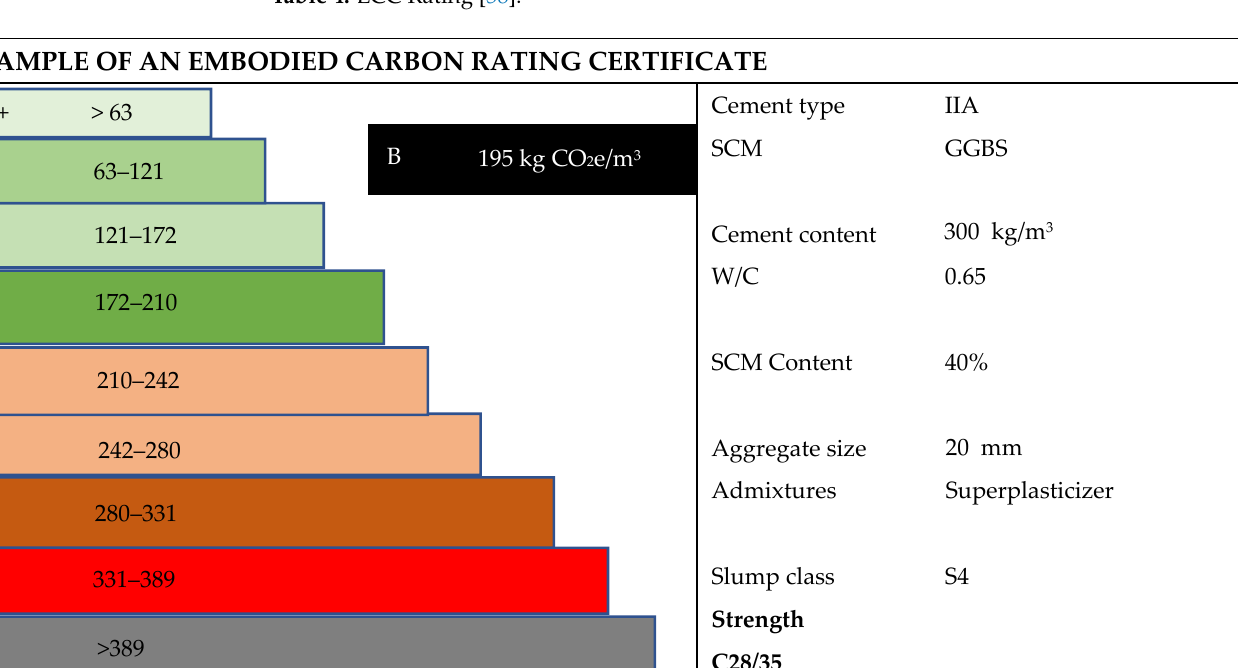
Table 4. LCC Rating [58].